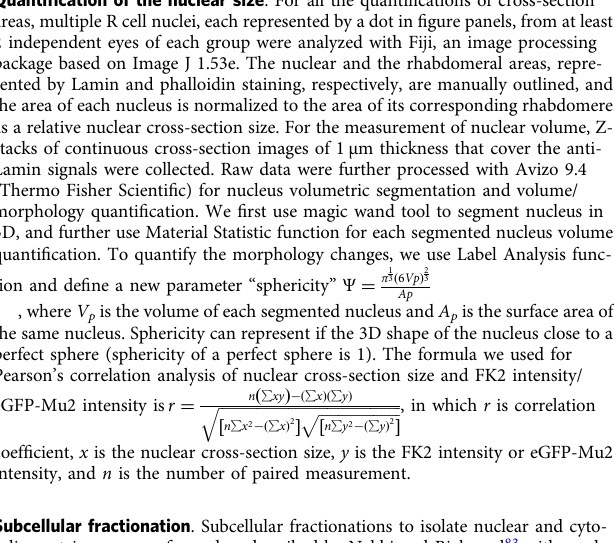
Fig. 6 TER94 dysfunction triggers nuclear expansion through p53A-mediated autophagy blockage. a , b Confocal micrographs of 7-day-old Rh1 > TER94 K2A > GFP-Atg8a ( a ) or Rh1 > TER94 K2A > GFP-p62 ( b ) retinas co-expressing p53-RNAi or Mu2-RNAi stained with phalloidin (red) and anti-Lamin (magenta). c Quanti fi cation of the GFP-Atg8a (upper panel) or the GFP-p62 (lower panel) intensity. In total, ≥ 4 independent eyes are measured. d Left: Confocal micrographs of 5-day-old retinas from Rh1 > LacZ or Rh1 > TER94 K2A co-expressing GFP-mCherry-Atg8a. Control fl ies are treated by the indicated drugs. Anti-Lamin (magenta) marks nuclei. Puncta shown in separated channels are enlarged from the corresponded white boxes. Right: Fluorescence intensity plots of GFP and mCherry across the corresponded puncta. e Dot plot of mCherry and GFP fl uorescent intensity from the tested group in d . The determination of X - and Y -axis and the de fi nition of each quadrant are disclosed in Methods. f Quanti fi cation of puncta distribution in each quadrant. g Ratiometric analysis of GFP/mCherry fl uorescent intensity. Puncta from 6 independent eyes are measured. h Dot plot of mCherry and GFP intensity from puncta in Rh1 > LacZ and Rh1 > Mu2 fl ies co-expressing GFP-mCherry-Atg8a. i Quanti fi cation of puncta distribution in each quadrant and j ratiometric analysis of GFP/mCherry fl uorescent intensity. Puncta from 6 independent eyes are measured. k Top: Confocal micrographs of 5-day-old adult retinas expressing LacZ, and Mu2 with LacZ or indicated p53 isoforms stained with phalloidin (red), anti-Lamin (magenta), and anti-ref(2)p (green). Bottom: Quanti fi cation of the cross-section area of R1-R6 nuclei. Quanti fi cation details of c , f , g , i , j , and k are listed in Statistics and reproducibility. Scale bars: 10 µ m ( a , b , d regular panels, k ), 2 μ m ( d enlarged panels). l A model depicts loss of VCP function triggers MDC1 – p53-mediated autophagy blockage and nuclear expansion. VCP regulates MDC1 retention on damaged foci. Loss of VCP function causes MDC1 accumulation by which to stabilize its